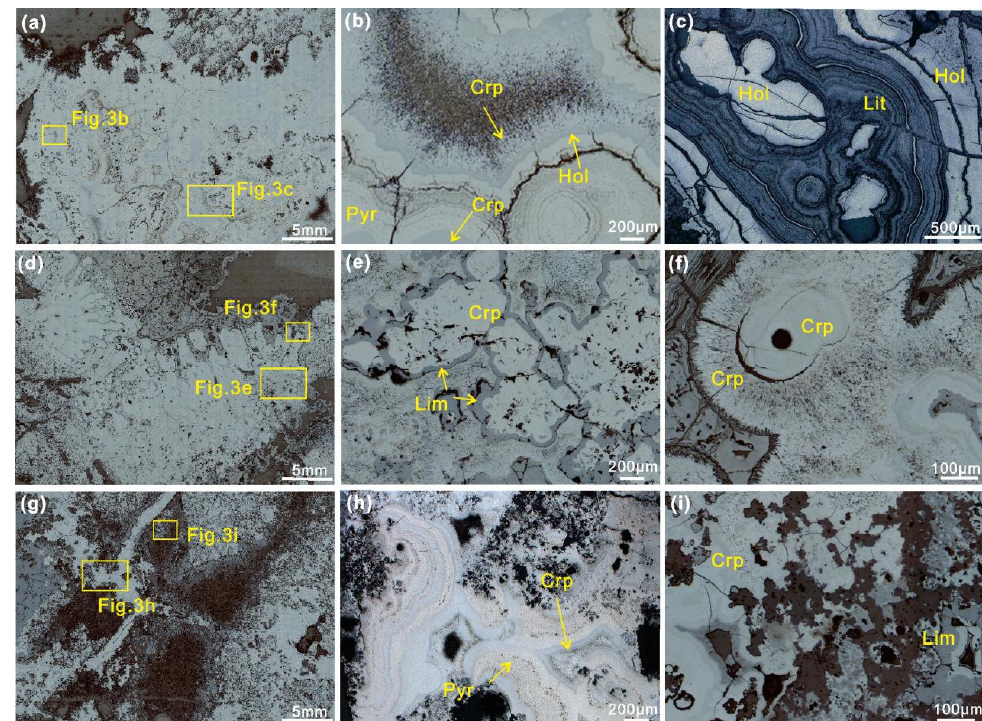
Figure 3. Reflected light micrographs of the mineralogy and textures of the Mn-oxide ore in the Xiangtan deposit. ( a , d , g ) Cryptocrystalline Mn oxide with colloidal structure.; ( b ) Cryptomelane showing light whitish green to off-white reflection color, fibrous and radial texture; ( c ) Hollandite and lithiophorite, annule texture; ( e , i ) The thin, limonite microscopic layers around the cryptomelane; ( f ) Cryptomelane with different mineralization stages; ( h ) Pyrolusite showing creamy yellow tint reflection color and a parallel banded structure. Crp—cryptomelane; Hol—hollandite; Pyr—pyrolusite; Lit—lithiophorite; Lim—limonite.